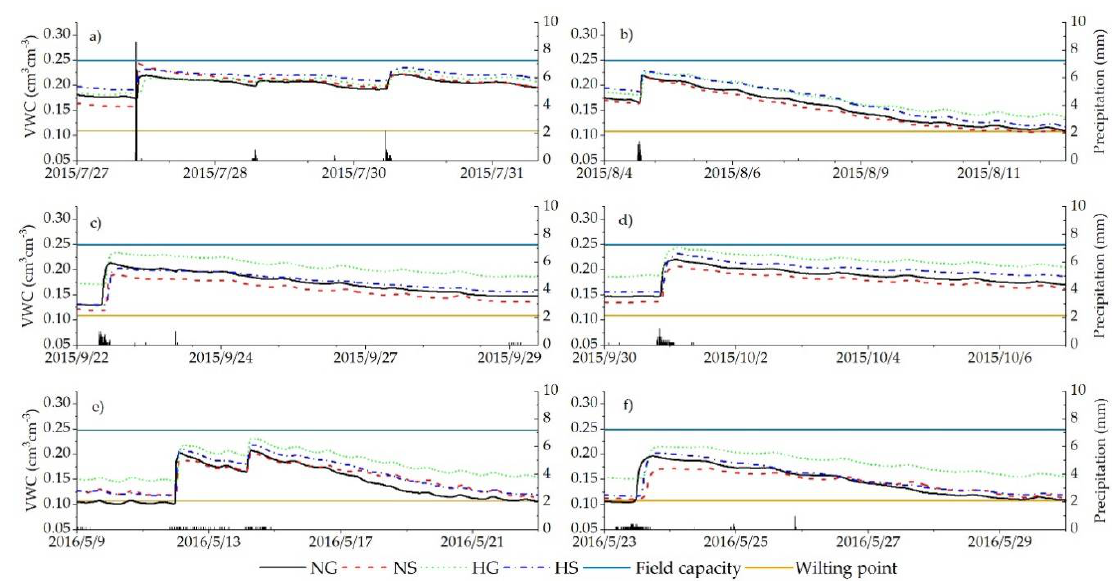
Figure 4. The variation of soil volumetric water content (VWC) at soil depths of 0–10 cm after rainfalls. ( a ) 16 mm, 2.6 mm, 6.3 mm; ( b ) 9 mm; ( c ) 12 mm; ( d ) 11.2 mm; ( e ) 7.8 mm, 5 mm; ( f ) 10.8 mm. The field capacity and wilting point refer to Yu et al. [44].